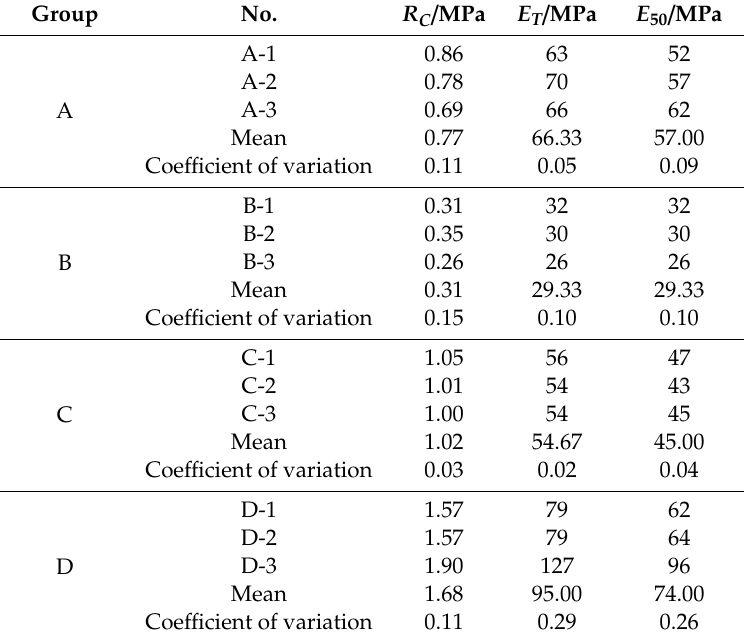
Table 3. The uniaxial compression test results of briquettes with different particle sizes. Group